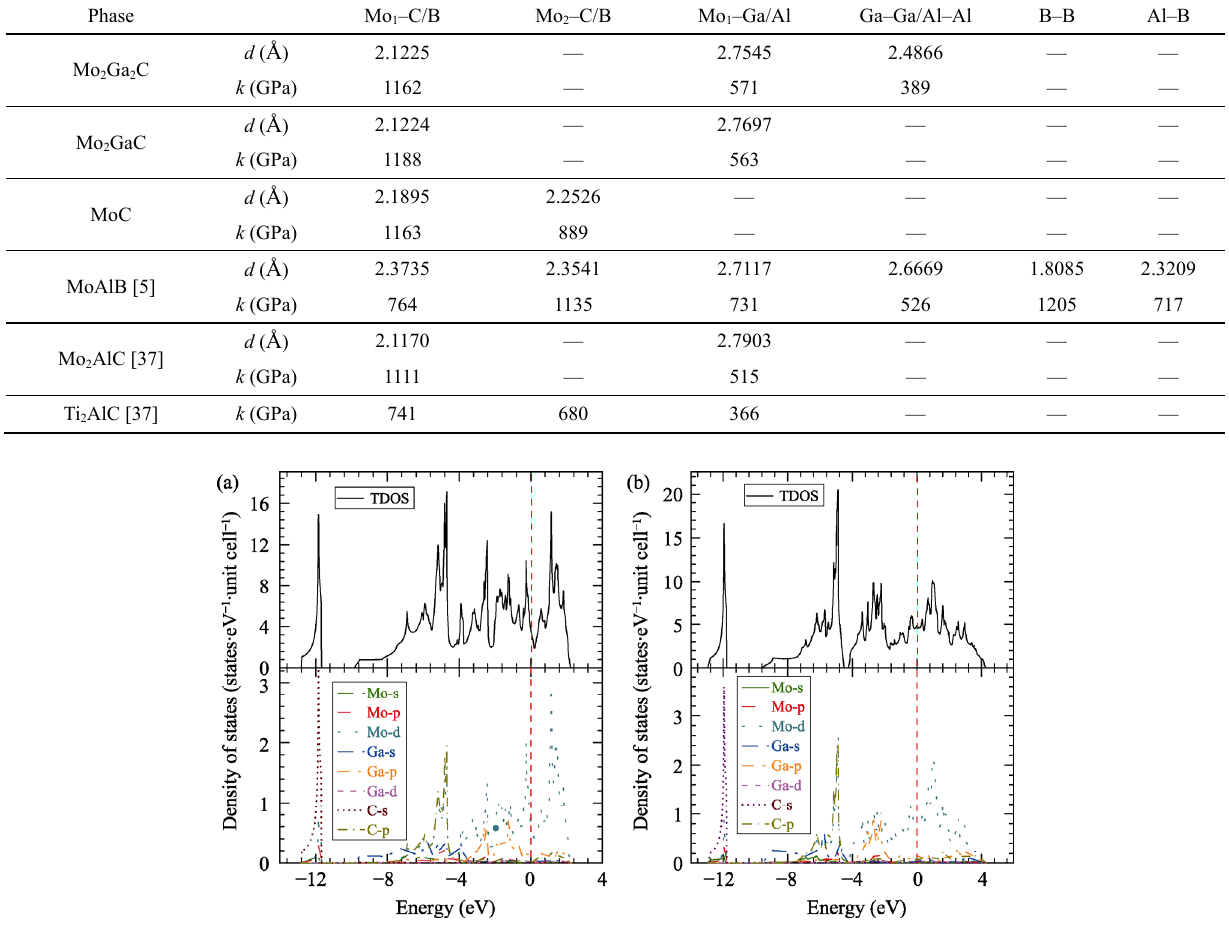
Fig. 2 Total and partial densities of states of (a) Mo 2 Ga 2 C and (b) Mo 2